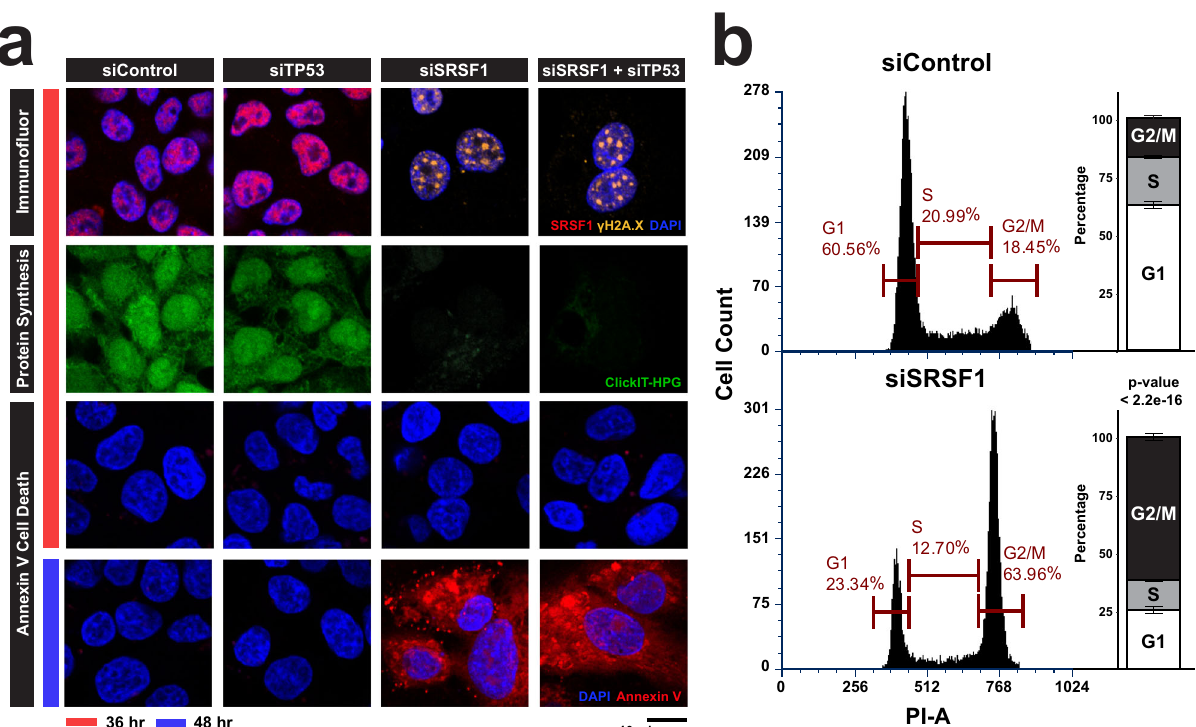
Fig. 9 | Acute knockdown of SRSF1 in HepG2 recapitulates SRSF1 HKO pathology.a HepG2cellswereculturedandtreatedwiththeindicatedsiRNAfor36 and 48h before performing the speci fi ed assays. First Row: Immuno fl uorescent staining for SRSF1 (red), γ H2A.X (yellow), and nuclear (blue) after 36h of knock- down with the speci fi ed siRNA. Second Row: Qualitative assessment of nascent protein synthesis (green) of the same fi eld shown in the fi rst row using a fl uorescent-based ClickIT-HPG incorporation assay. Third and Fourth Rows: Annexin V staining (red) for cell death of HepG2 cells at 36 and 48h post